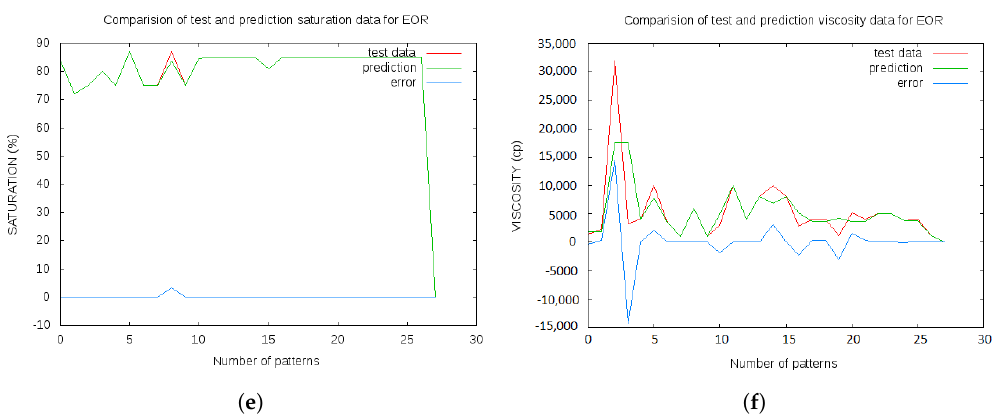
Figure 12. Plots of the weighted testing data, prediction data and associated error versus number of patterns for steam (Area 1): ( a ) API; ( b ) depth; ( c ) permeability; ( d ) porosity; ( e ) saturation; and ( f )